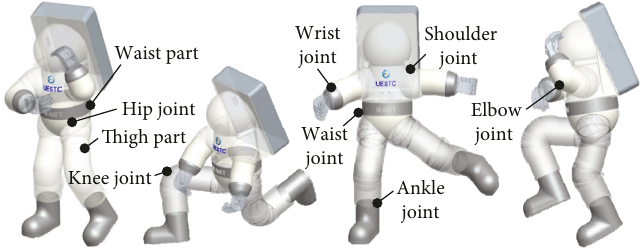
Figure 1: Four basic lower extremity activities of designed spacesuit.